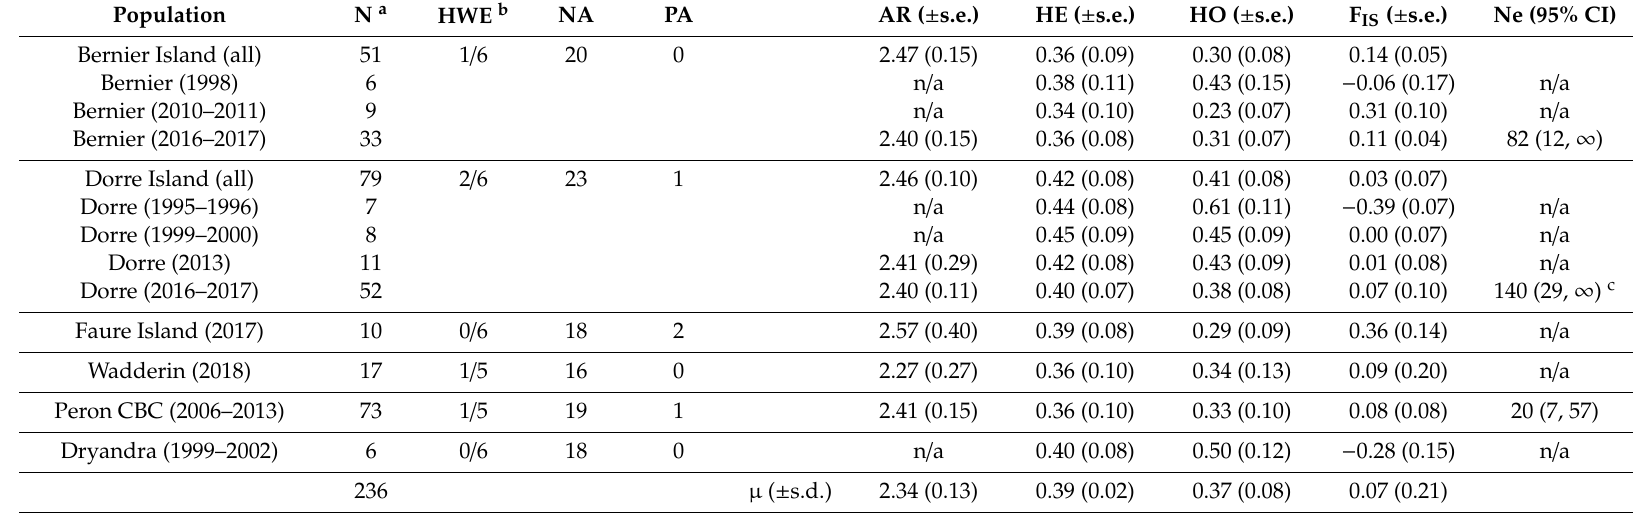
Table 3. Population-level diversity metrics using seven polymorphic microsatellite